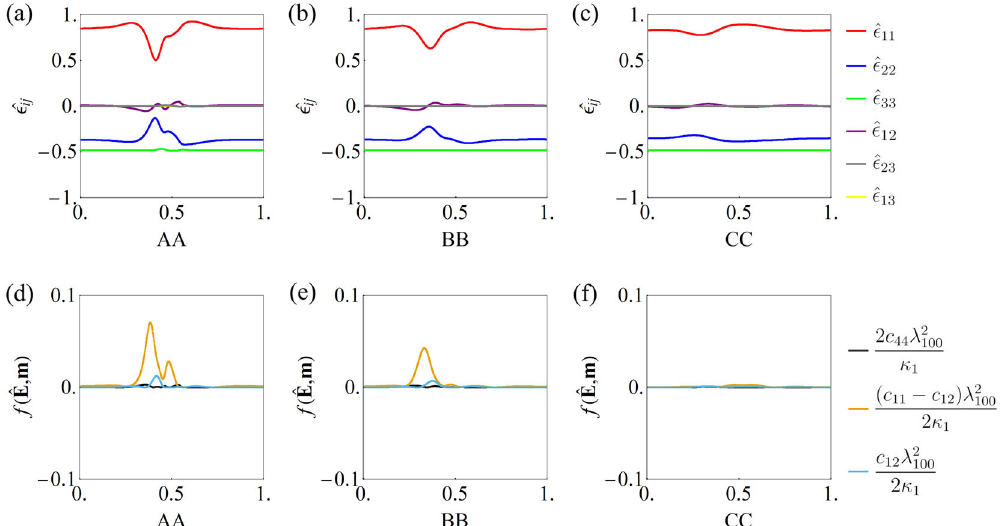
Fig. 7 The strain and elastic energy distribution across the needle domain. a – c The strain distribution ^ ϵ ij across lengths “ AA ” , “ BB ” , and “ CC ” (as marked in Fig. 6(d)) in the computational domain. The strain distribution from the simulation, ^ ϵ 11 (cid:3) 1 , ^ ϵ 22 (cid:3) ^ ϵ 33 (cid:3) (cid:2) 0 : 5 , is consistent with the theoretical analysis in Fig. 6(a). The strains at the domain walls near the spike domain vary, indicating the diffuseness of the walls. The shear strains are mostly zero throughout the computational domain. ( d – f ) A plot of the three polynomials f ð ^ E ; m Þ that accompany coef fi cients 2 c 44 λ 2 100 ð c 11 (cid:2) c 12 Þ λ 2 100 , and c 12 λ 2 100 in Eq. (5). In line with our hypothesis the polynomials accompanying 2 c 44 λ 2 100 κ κ 1 , 2 κ 1 2 κ 1 contributions for magnetization reversal at the transient state of the spike domain, and the polynomial accompanying ð c 11 (cid:2) c 12 Þ λ 2 100 energy barrier for magnetization reversal at the transient domain state.